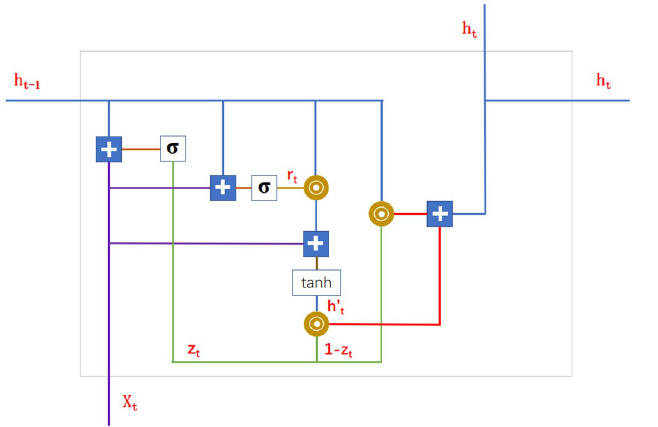
Fig 2. GRU structure diagram.